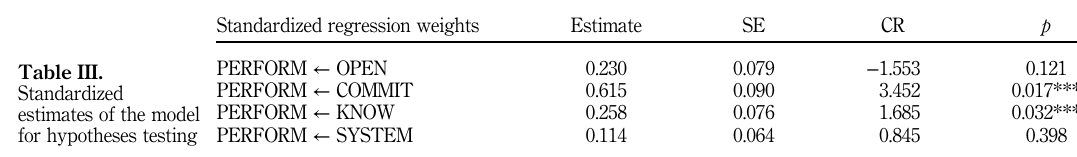
Table III. Standardized estimates of the model for hypotheses